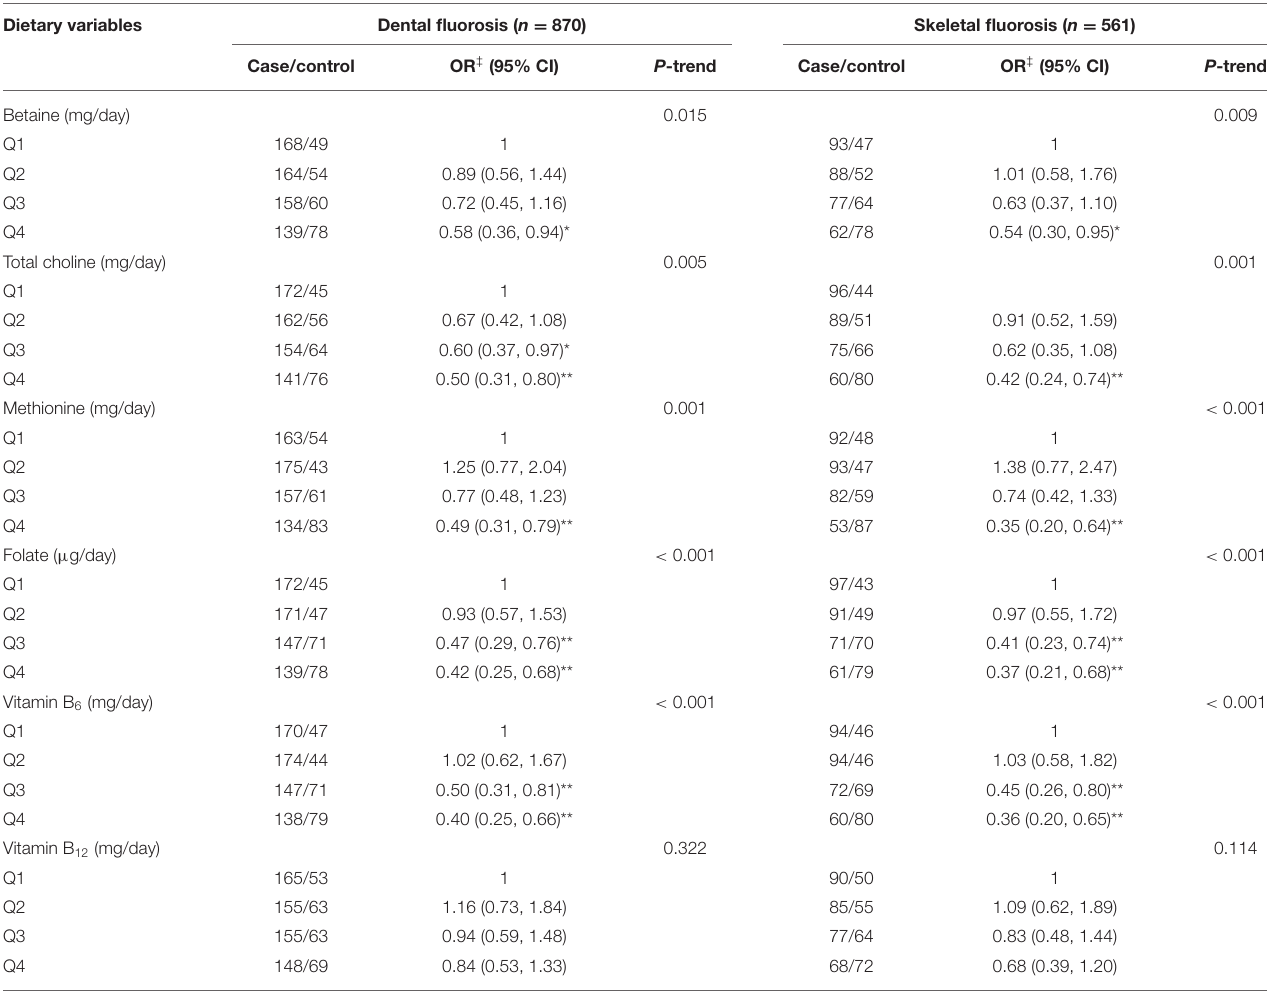
‡ See Table 3 for the covariates. * p < 0.05, ** p <